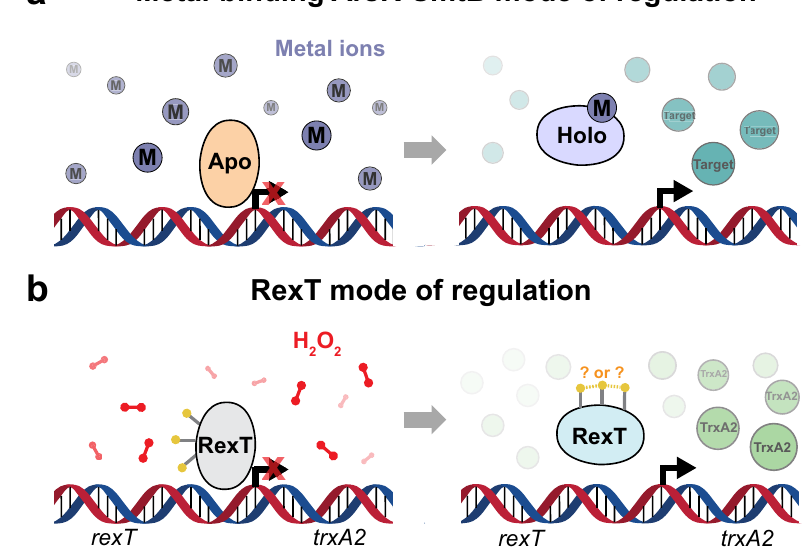
Fig. 1 The ArsR-SmtB family of transcriptional regulators act as repressors of their target genes. a The metal-binding members of the ArsR-SmtB class act as repressors of the target gene in the apo-state. In contrast, when bound to a metal ion, a conformational change ensues, and transcription of the target gene is initiated 23,24 . b RexT is a non-canonical member of the ArsR-SmtB family of transcriptional regulators. Rather than binding metal ions, RexT is proposed to respond to H 2 O 2 stress through formation of a disul fi de bond that initiates transcription of the thioredoxin-encoding gene trxA2 17